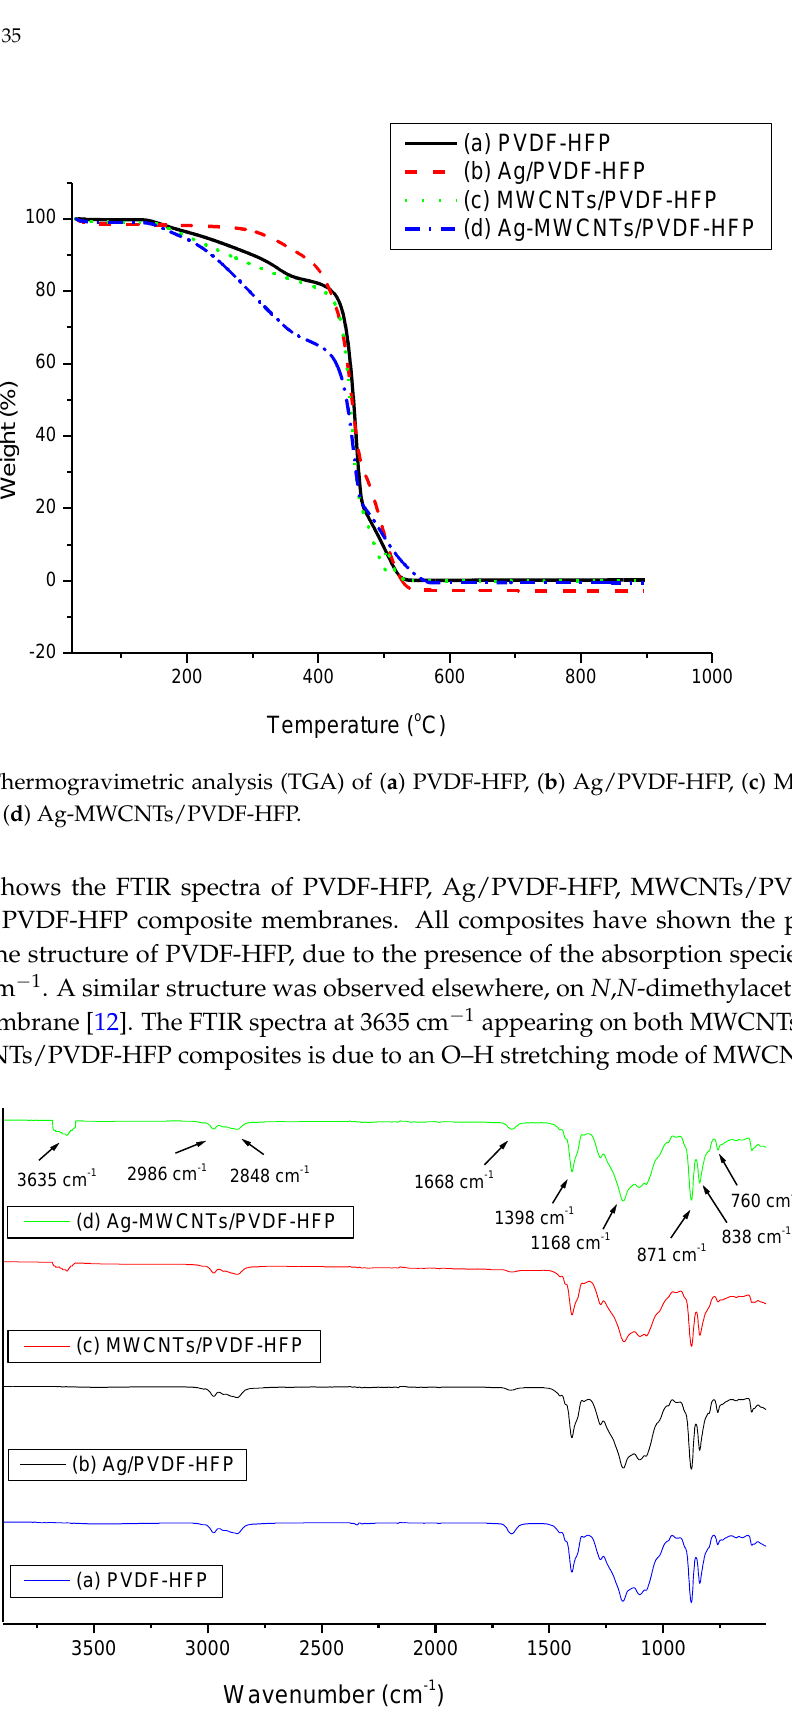
Figure 4. Fourier transform infrared (FTIR) spectra of ( a ) PVDF-HFP, ( b ) Ag/PVDF-HFP, ( c ) MWCNTs/PVDF-HFP, and ( d ) Ag-MWCNTs/PVDF-HFP.